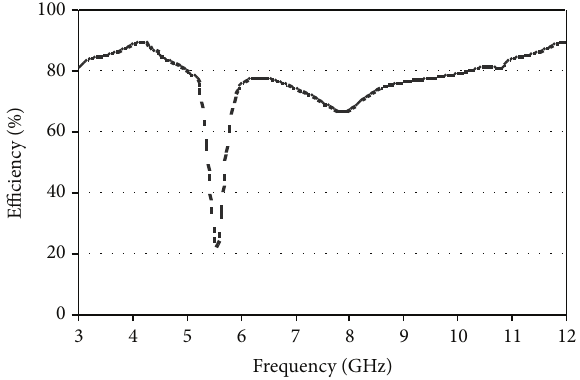
Figure 10: Radiation efficiency of the proposed antenna.